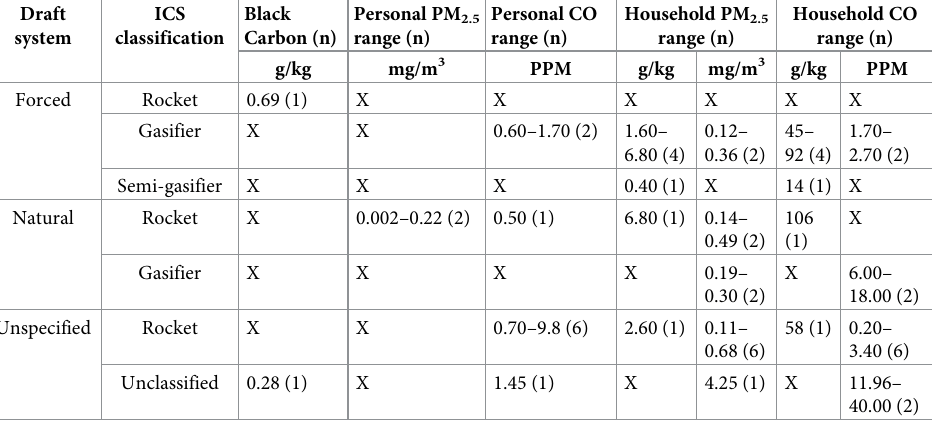
Table 4. A snapshot of heterogeneous characteristics, units of measurement and range of HAP emission by ICS. Draft